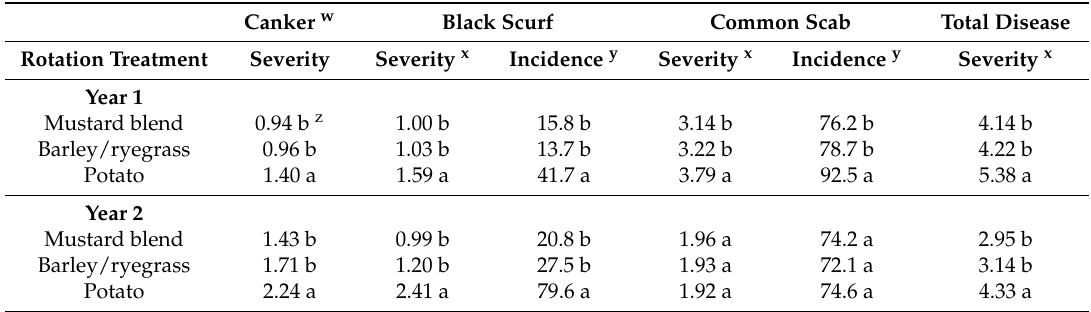
Table 4. Development of soilborne potato diseases at the Newport site as affected by previous rotation crop in Year 1 and Year 2 of potato